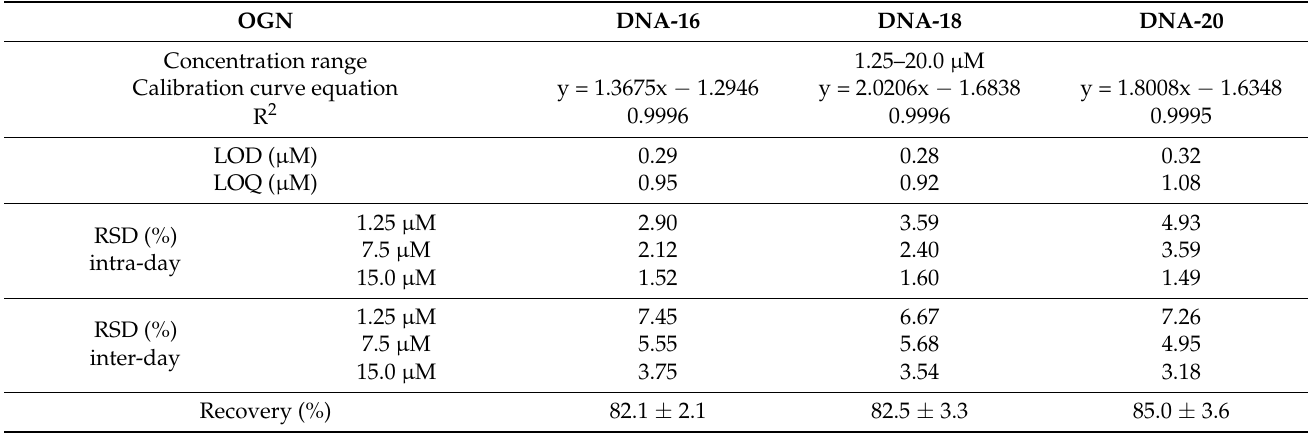
Table 5. Calibration curve parameters and validation parameters for determined OGNs. Abbreviations: OGN— oligonucleotide; R 2 —coefficient of determination; LOD—limit of detection; LOQ—limit of quantification; RSD—relative standard deviation. OGN DNA-16 DNA-18 DNA-20 Concentration range 1.25–20.0 µ M Calibration curve equation y = 1.3675x −